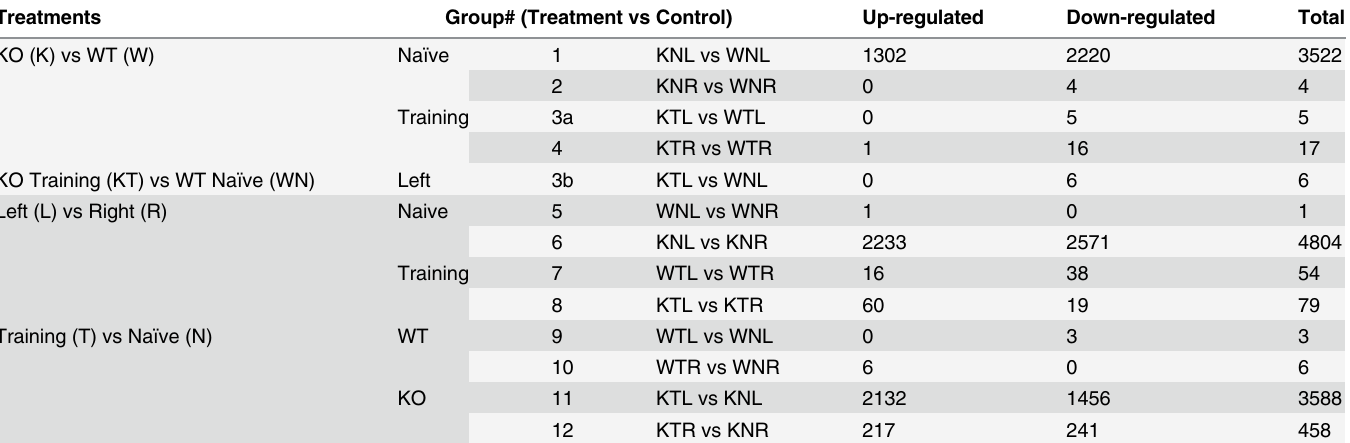
Table 1. Numbers of differentially expressed genes (DEGs) in each microarray comparison .